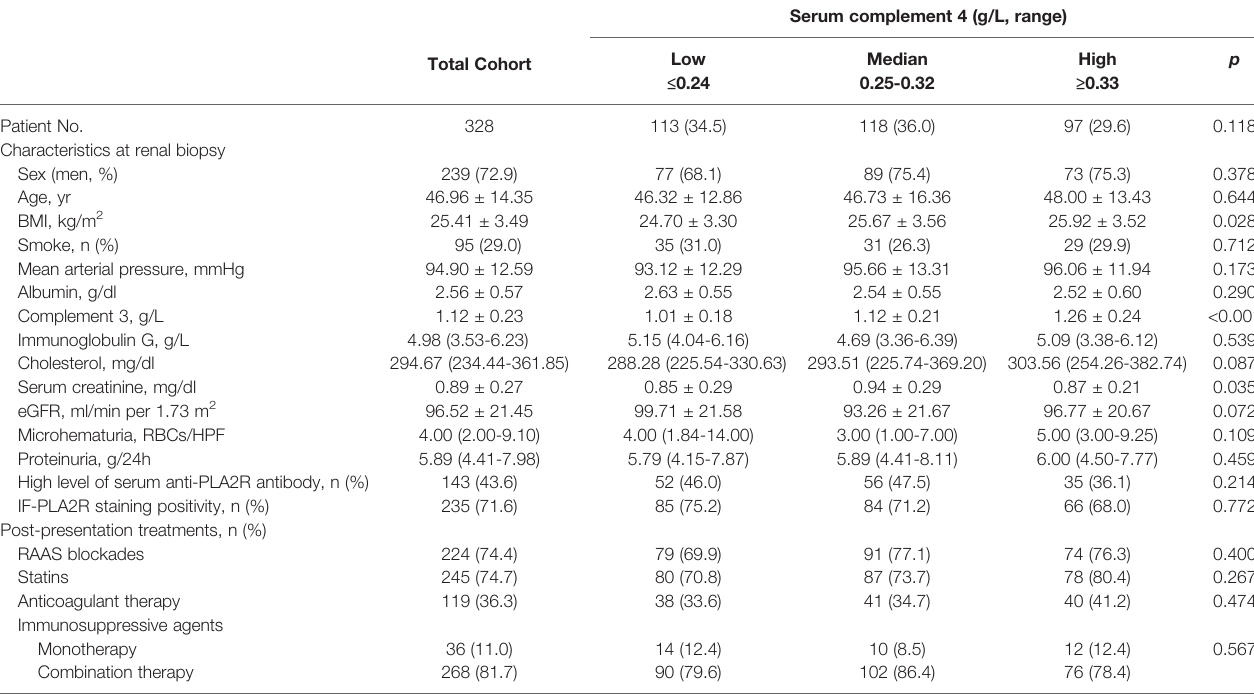
TABLE 1 | Characteristics of patients at presentation and subsequent treatments received.